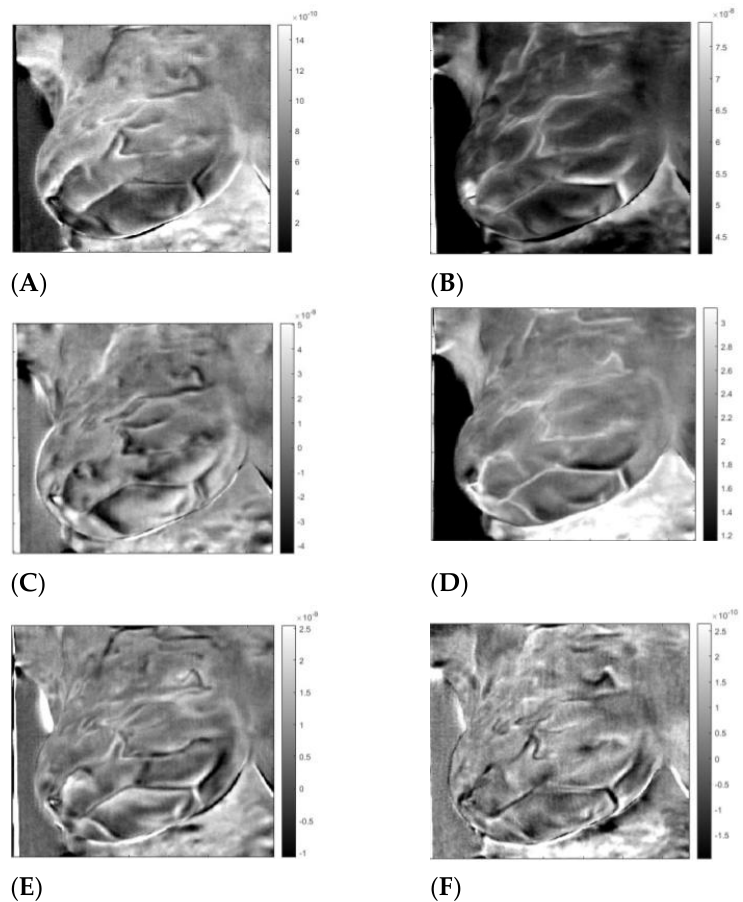
Figure 2. Thermal images of patient “T281” ; right breast after VWT and PCA. Images A to F are individuzal PCA vectors converted to images ( A – F ).